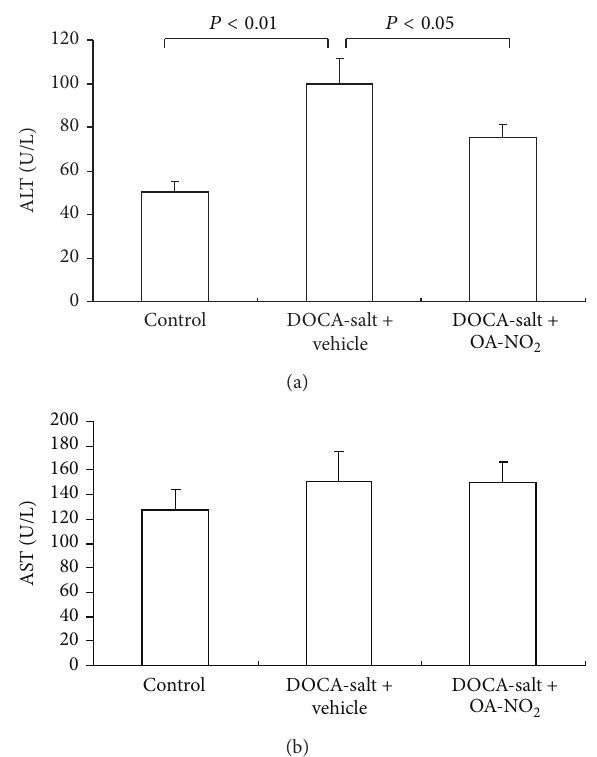
Figure 4: Effect of OA-NO 2 on plasma AST and ALT after 3-week DOCA-salt treatment. Control: 𝑛 = 5 ; DOCA-salt + vehicle: 𝑛 = 8 ; DOCA-salt + OA-NO 2 : 𝑛 = 8 . Data are shown as mean +